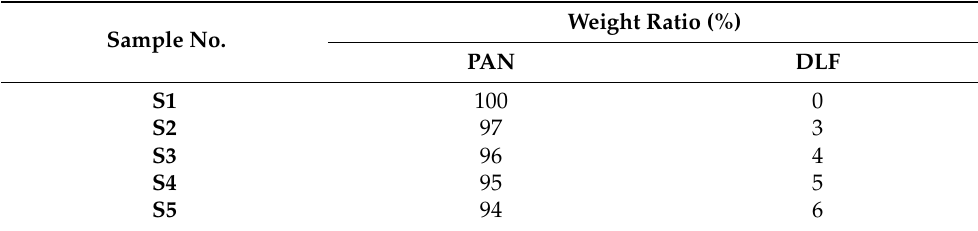
Table 1. Composition of electrospinning solution. Sample